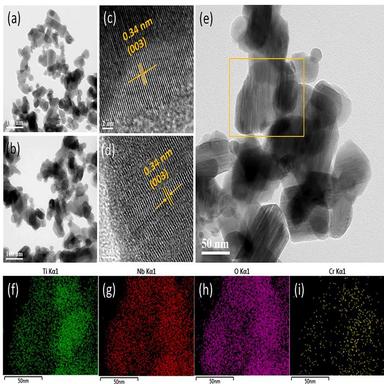
Morphological investigation of Cr-TNO. (a, b) TEM and (c, d) HRTEM images of (a, c) TNO and (b, d) Cr-TNO. (e) Representative TEM image with the associated EDX mapping of Cr-TNO (yellow square). (f–i) EDS mapping of (f) Ti, (g) Nb, (h) O, and (i) Cr atoms in the Cr-TNO powder.